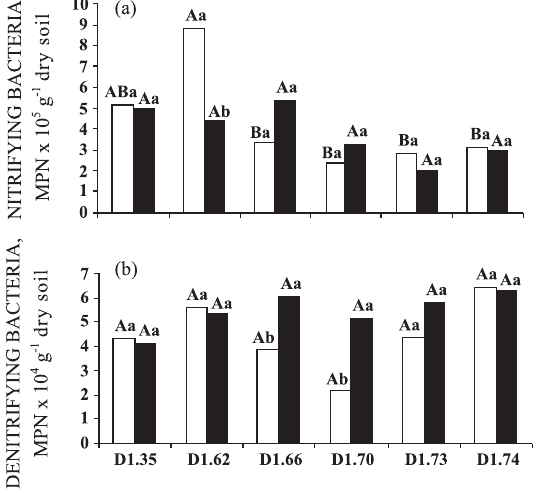
Figure 2. Nitrifying (a) and denitrifying (b) populations found in the layers 0–10 (